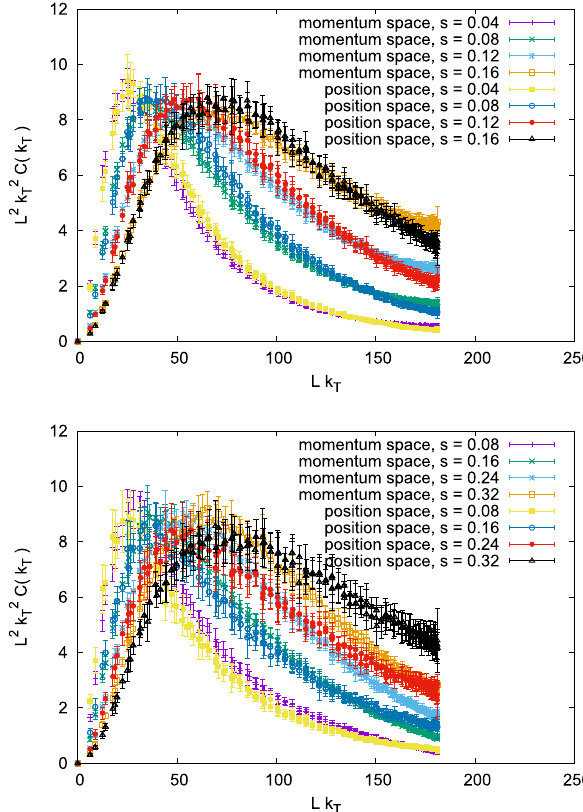
Fig. 15 Comparison of gluon densities obtained with evolution imple- mented in position and momentum spaces using the “square root” (top) and noise (bottom) α s prescriptions on a lattice with extent L / a =